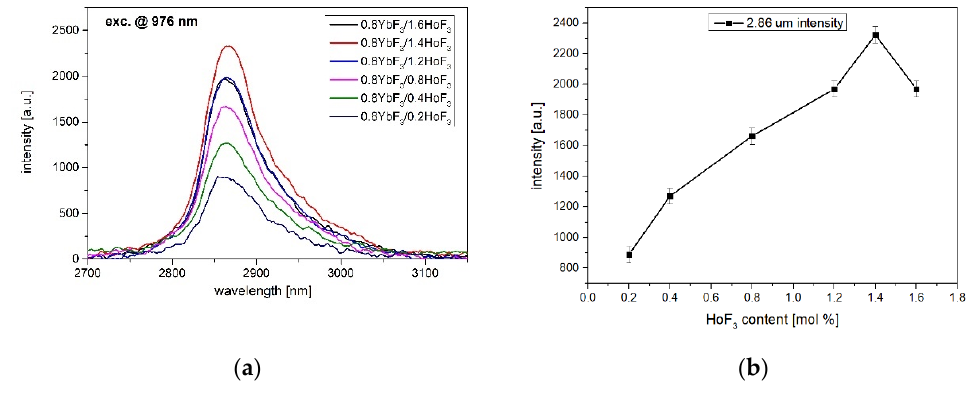
Figure 3. ( a ) Mid-IR luminescence spectra, ( b ) 2.86 μ m emision intensity of 0.8YbF 3 /(0.2–1.6)HoF 3 co-doped fluoroindate glasses, λ exc = 976 nm.